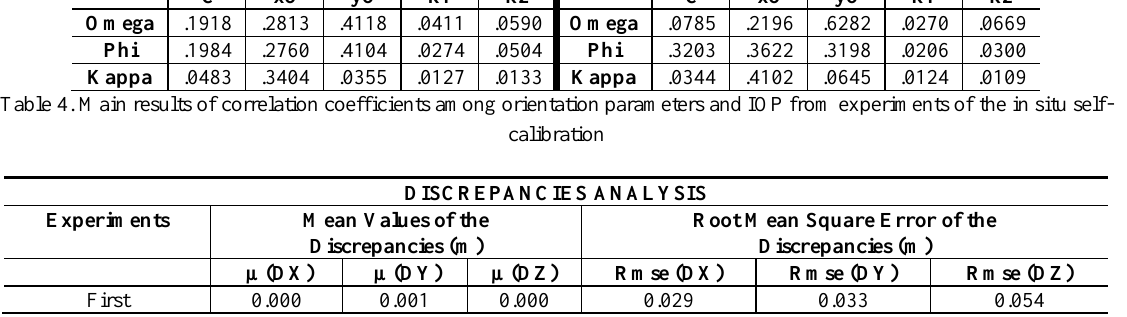
Table 5. Main results of discrepancy analysis performed in the first experiment of the in situ self-calibration